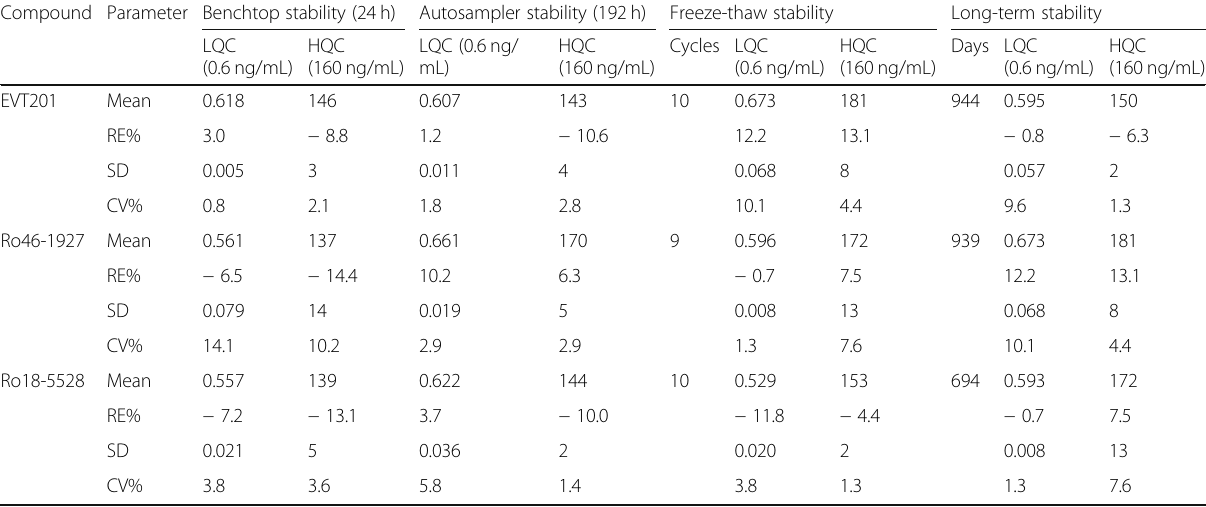
Table 3 Summary of stability